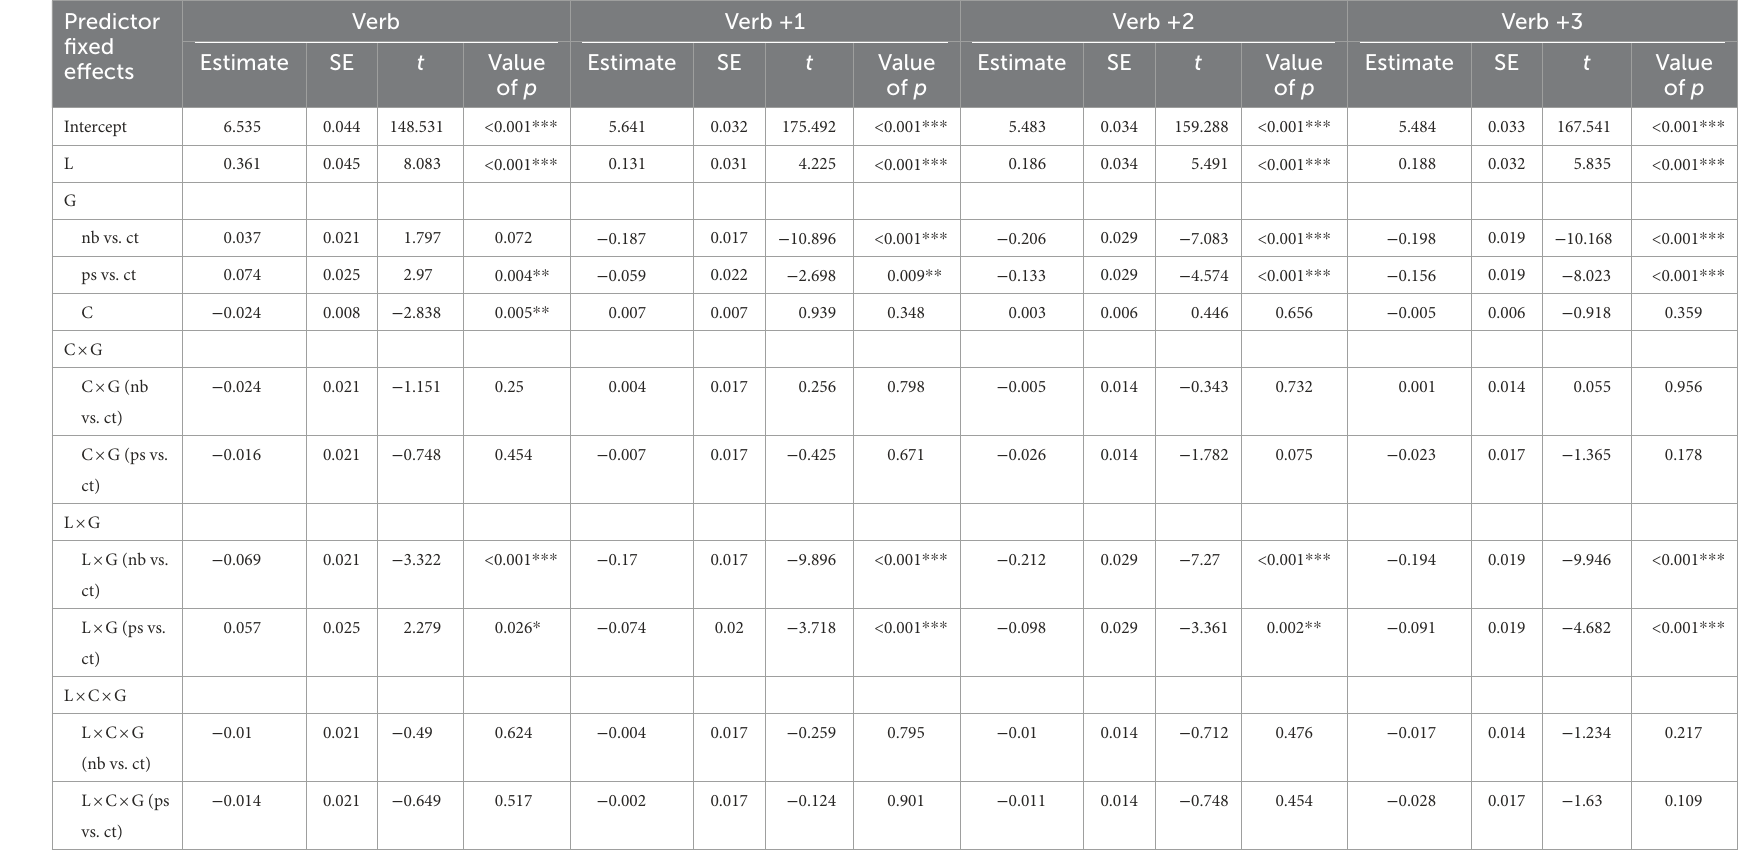
TABLE 4 Summary of the linear mixed effect models for the comparison between number and person violations. Predictor